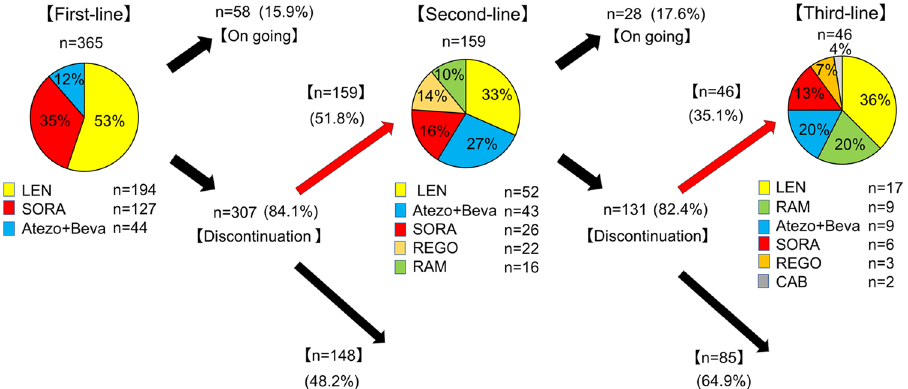
Figure 1. Conversion rate to later-line sequential therapy and therapeutic agents. The yellow, red, blue, orange, green, and gray blocks indicate LEN, SORA, atezolizumab plus bevacizumab, SORA, REGO, RAM, and CAB, respectively. Abbreviations: LEN, lenvatinib; SORA, sorafenib; REGO, regorafenib; RAM, ramucirumab; CAB, cabozantinib.